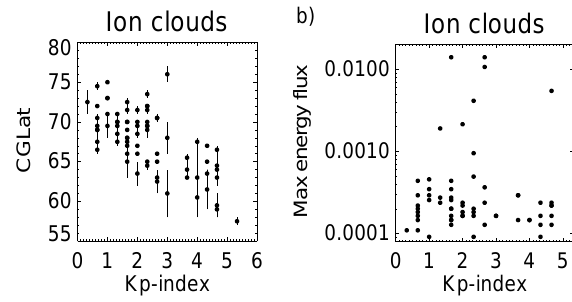
Fig. 5. (a) Variation in ion cloud CGLat (centers are marked by dots and extension by lines) with geomagnetic activity, Kp - index. (b) Relation between Kp -index and maximum flux (ergs cm − 2 st − 1 s − 1 eV − 1 )) in ion